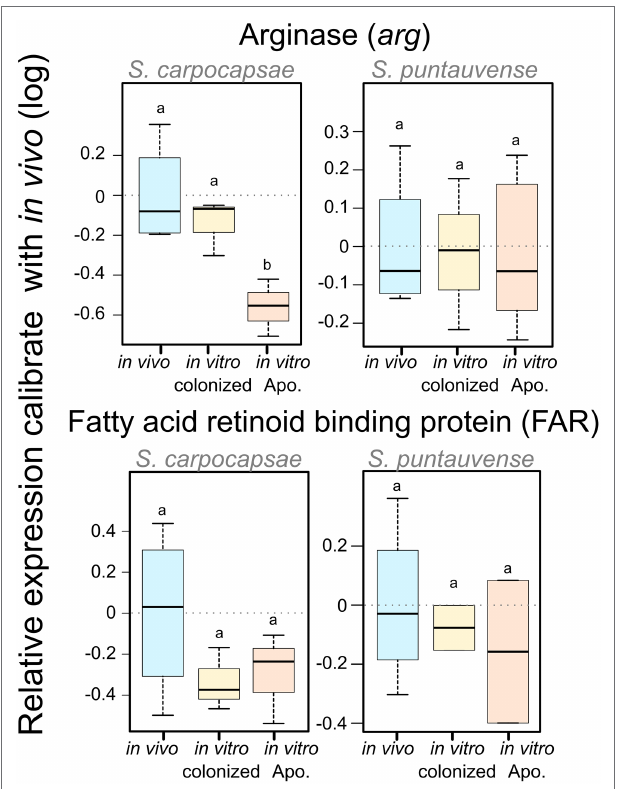
FIGURE 7 | Boxplot of the relative expression of one transcript involved in trehalose metabolism ( tps ), one transcript involved in arginine metabolism ( arg ) and one transcript coding FAR protein using qRT-PCR. The relative expression was calculated using a modified Pfaffl model normalized with the two-housekeeping genes, actin and MCM that was calibrated with the value detected for the in vivo reared IJs’ RNA. Boxplot presents the log of the calculated relative expression. Differential expression was tested by either one way ANOVA associated with post- hoc Tukey’s HSD or the non-parametric Kruskal-Wallis rank sum associated with multiple pairwise comparisons using the Dunn’s test according to applicable condition. Bars labeled with the same letter are not significantly different from each other. See statistical test details in Supplementary Table S5